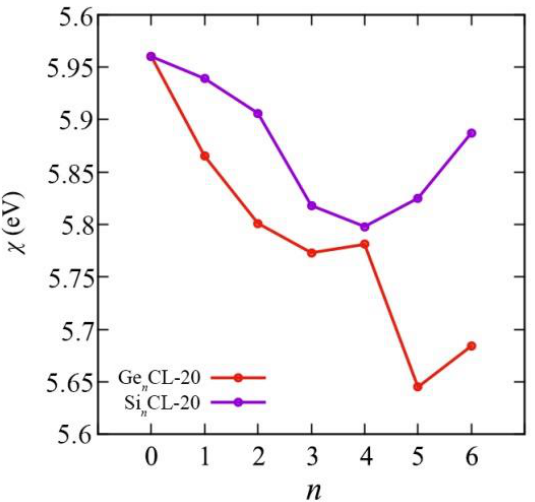
Figure 8. The electronegativity χ versus the number of Si-/Ge-atoms n in the Si n CL-20/Ge n CL-20 molecules for the most thermodynamically stable configurations obtained at the DFT/B3LYP/6- 311(d,p) level of theory.